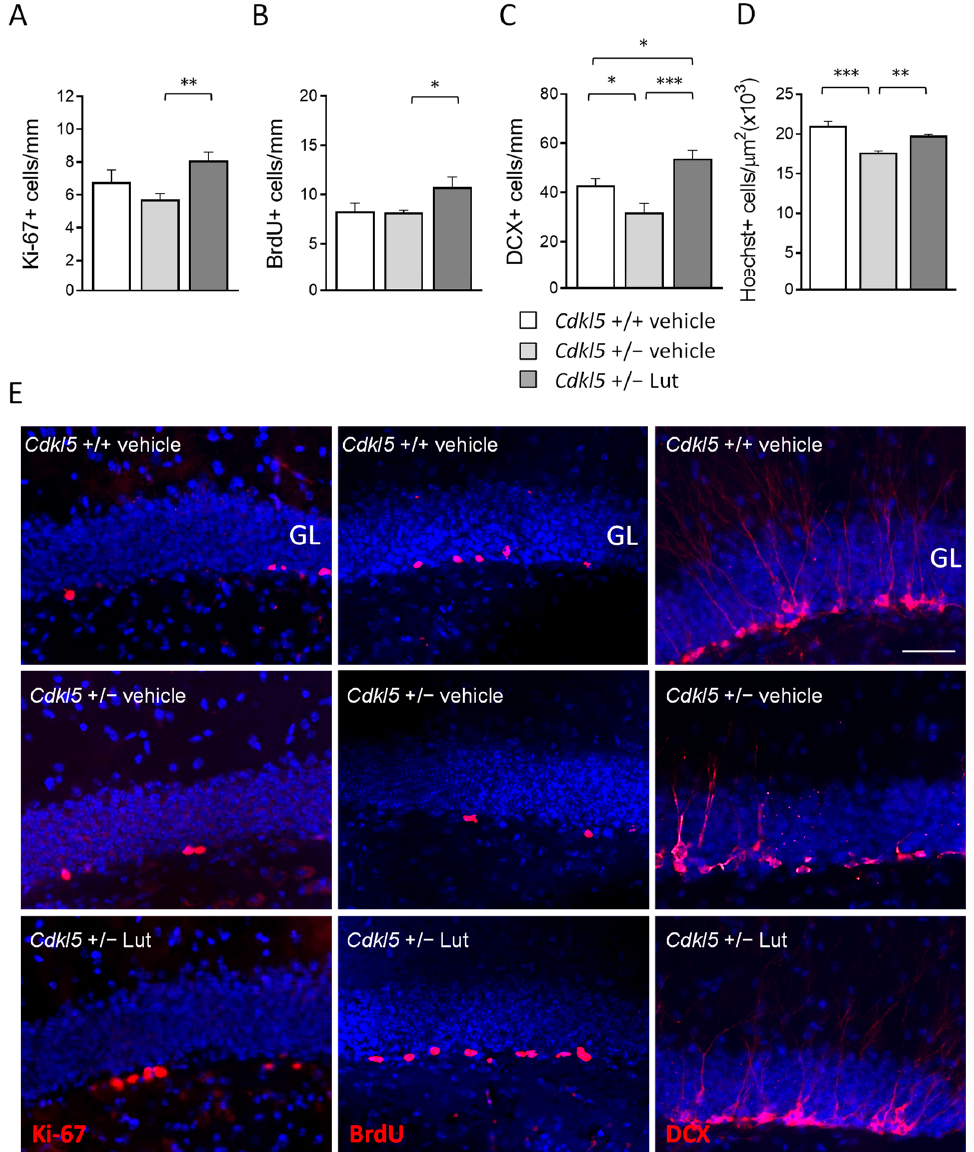
Figure 2. Effect of luteolin treatment on hippocampal neurogenesis of Cdkl 5 +/ − mice. ( A ) Number of Ki-67-positive cells in the subgranular zone (SGZ) of the dentate gyrus (DG) of vehicle-treated Cdkl 5 +/+ (n = 8) and Cdkl 5 +/ − (n = 9) mice and luteolin-treated Cdkl 5 +/ − (n = 8) mice. ( B ) Number of BrdU-positive cells in the SGZ of vehicle-treated Cdkl 5 +/+ (n = 4) and Cdkl 5 +/ − (n = 4) mice and luteolin-treated Cdkl 5 +/ − (n = 4) mice. ( C ) Quantification of DCX-positive cells in the granular layer (GL) of the DG of vehicle-treated Cdkl 5 +/+ (n = 7) and Cdkl 5 +/ − (n = 7) mice and luteolin-treated Cdkl 5 +/ − (n = 7) mice. ( D ) Quantification of Hoechst-positive cells in the GL of the DG of vehicle-treated Cdkl 5 +/+ (n = 4) and Cdkl 5 +/ − (n = 4) mice and luteolin-treated Cdkl 5 +/ − (n = 4) mice. ( E ) Examples of sections processed for fluorescent immunostaining for Ki-67 (left), BrdU (middle), and DCX (right) from the DG of an animal from each experimental condition. Scale bar = 50 µm. GL = granule cell layer. Values are represented as means ± SEM. * p < 0.05, ** p < 0.01, *** p < 0.001. Fisher’s LSD test after one-way ANOVA.